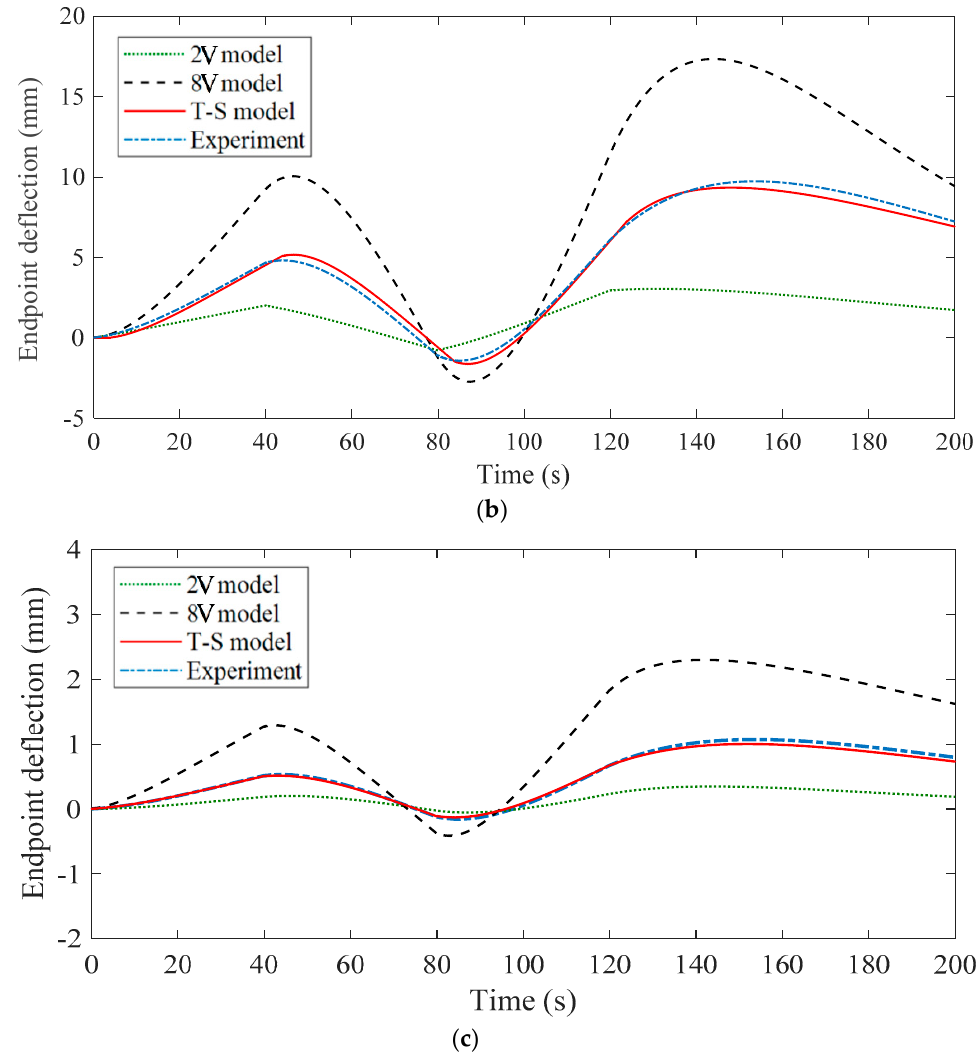
Figure 10. ( a ) Input voltage signal, ( b ) endpoint deflection of the arbitrary pattern actuator with size of S1, and ( c ) endpoint deflection of the lattice pattern actuator with size of S4.